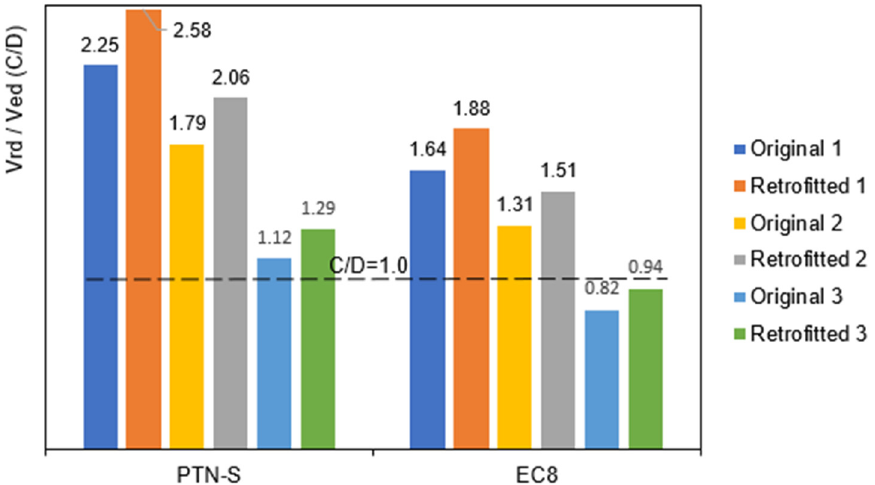
Figure 26. Seismic capacity versus demand (C/D) ratio for the ground floor of the building in E–W direction (for the original and retrofitted building).